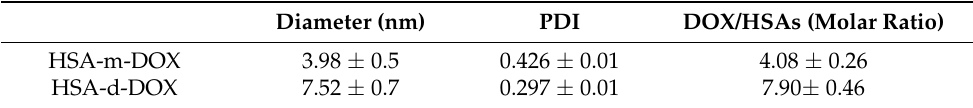
Figure 1. The preparation scheme of HSA-d-DOX, and the stability of HSA-m-DOX and HSA-d-DOX particles before and after lyophilization. ( A ) Preparation scheme of HSA-d-DOX. ( B ) The change of particle size and ( C ) DOX loading of HSA-DOX after lyophilization of HSA-m-DOX and HSA-d-DOX. Data are averages ± standard deviation ( n = 4). Table 1. Physicochemical characterization of HSA-m-DOX and